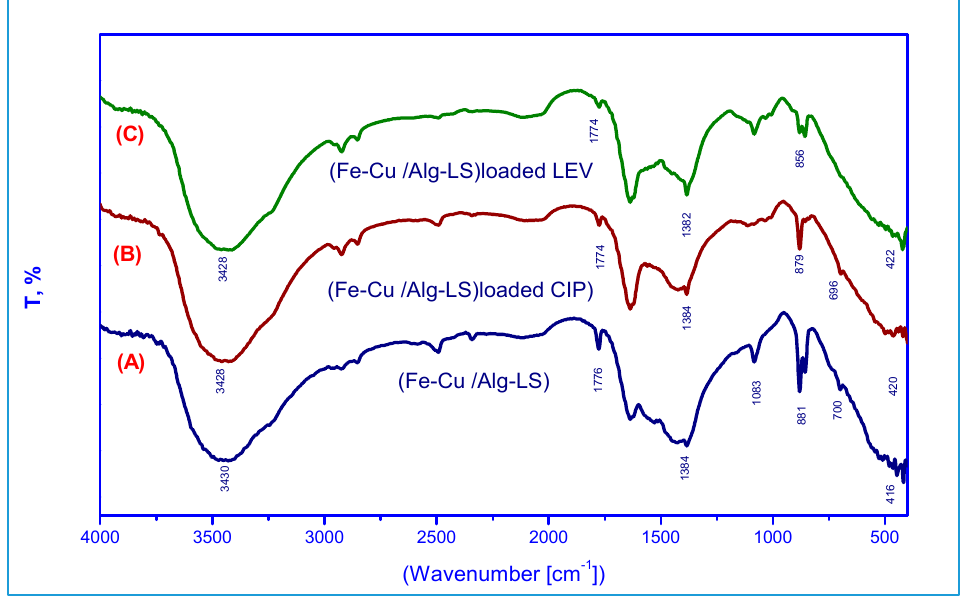
Figure 1. FTIR spectra of ( A ) the Fe − Cu/Alg − LS nanocomposite, ( B ) Fe–Cu /Alg − LS − loaded CIP, ( C ) Fe–Cu/Alg − LS -loaded LEV. ( C ) Fe–Cu/Alg–LS—loaded